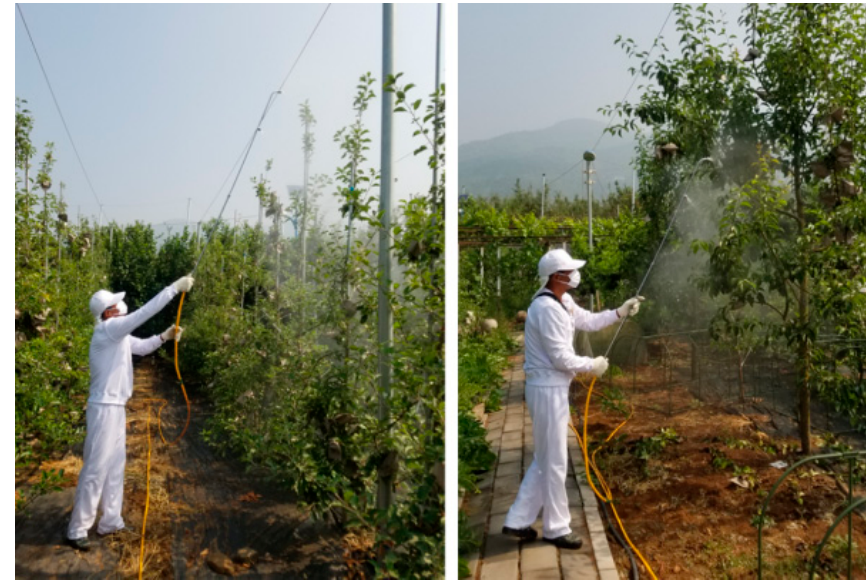
Figure 1. Stretcher-type power sprayer.